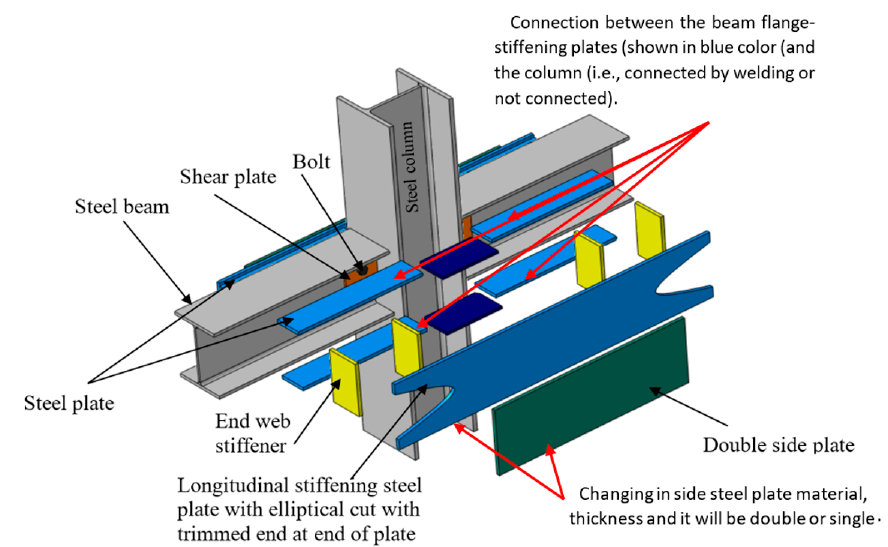
Figure 12. Details of strengthened joints used in the investigation study for J-S-S-EX. Table 4. Details of strengthened joints used in the investigation study for J-S-S-EX.